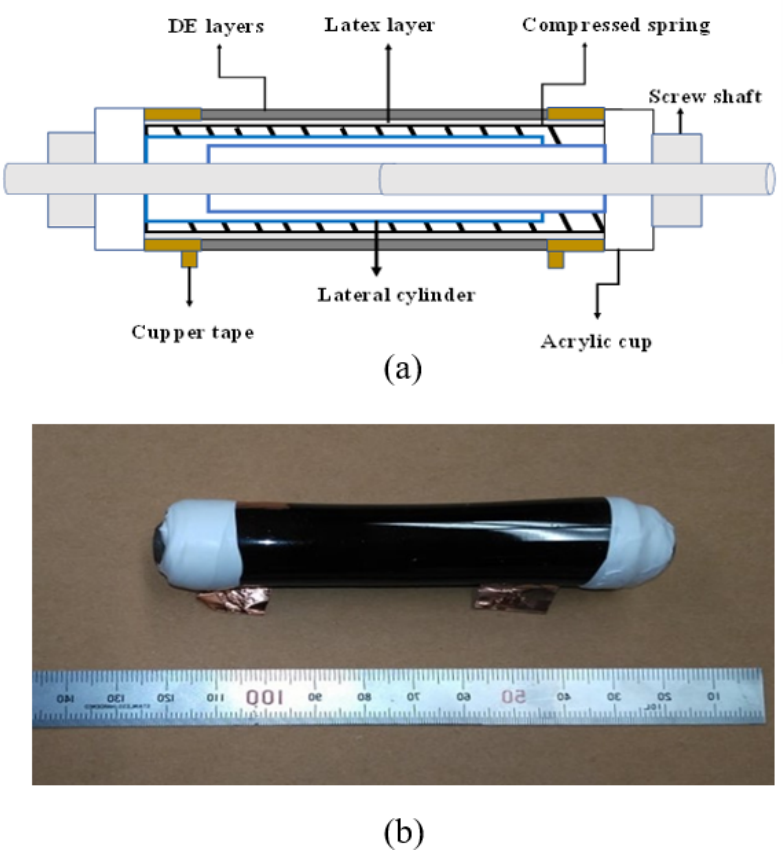
Figure 6. (a) The schematic design of the spring roll DE actuator, and (b) the fabricated DE